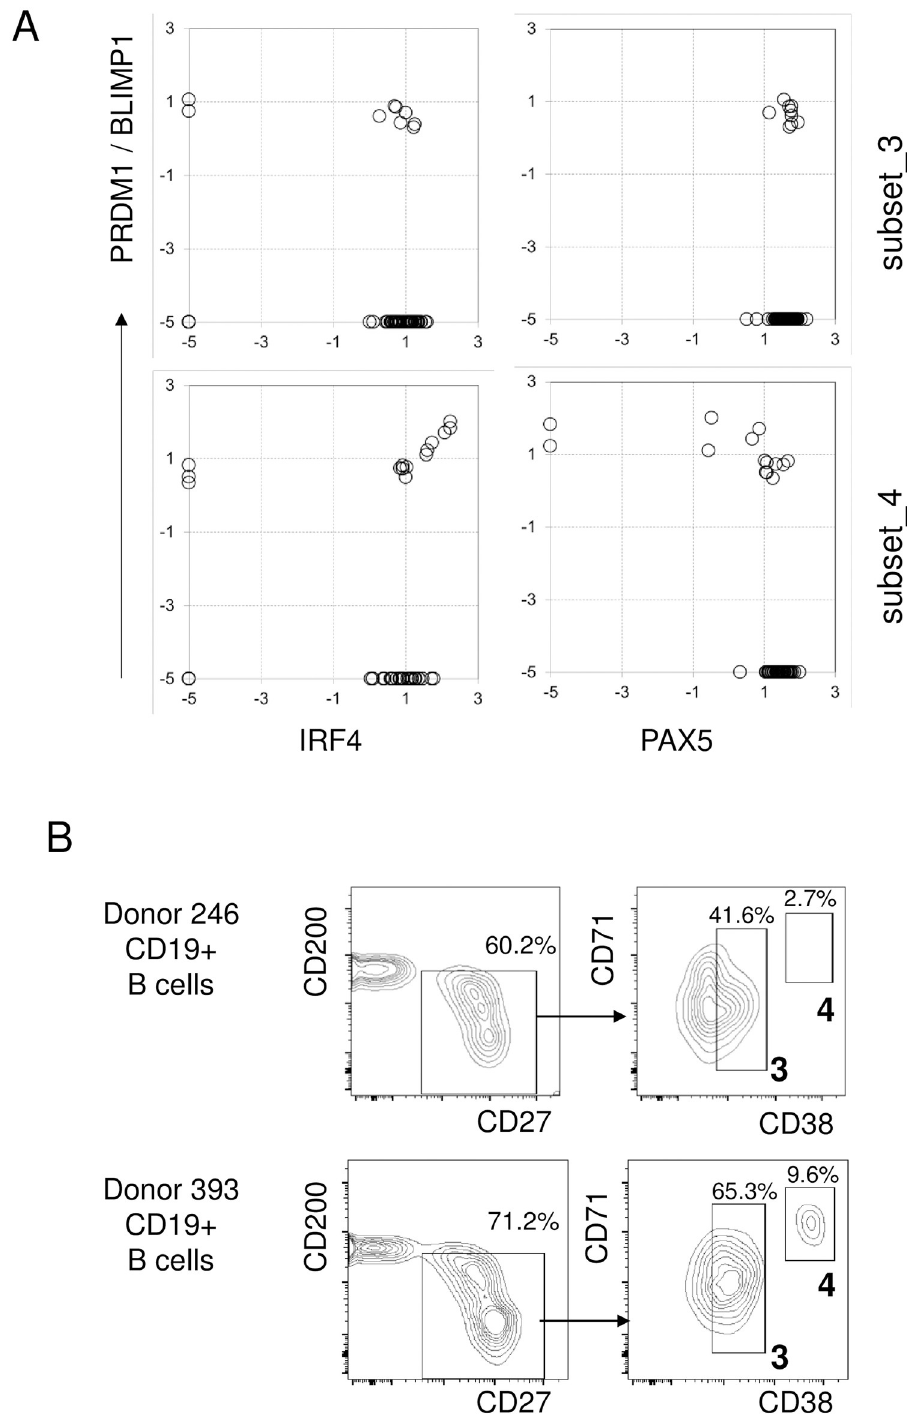
Fig 10. Expression of signature genes. (A) Expression of PRDM1/BLIMP (y axis, log(2) expression) vs. signature genes (x axis, log(2) expression) in subset_3 (upper row) and subset_4 cells (lower row). Each symbol represents an individual cell. (B) PBMC from a selected donor were analyzed in multicolor cytometry and sequentially gated for CD19+ B cells shown in the CD27/CD200 space (left panel); gated cells were then further resolved using CD38 and CD71 staining (right panel). Resolved subsets are boxed and numbered to match the R-PhenoGraph designation.